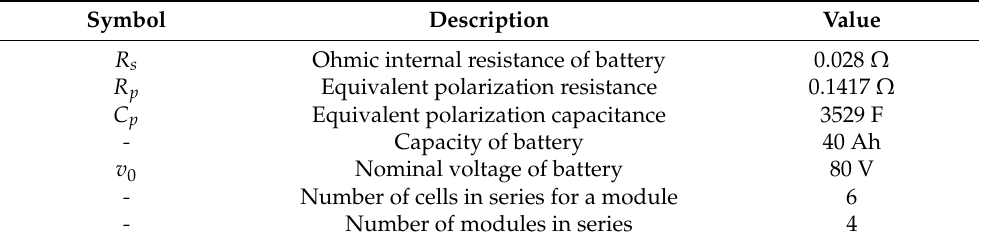
Table 2. Battery parameters [23].